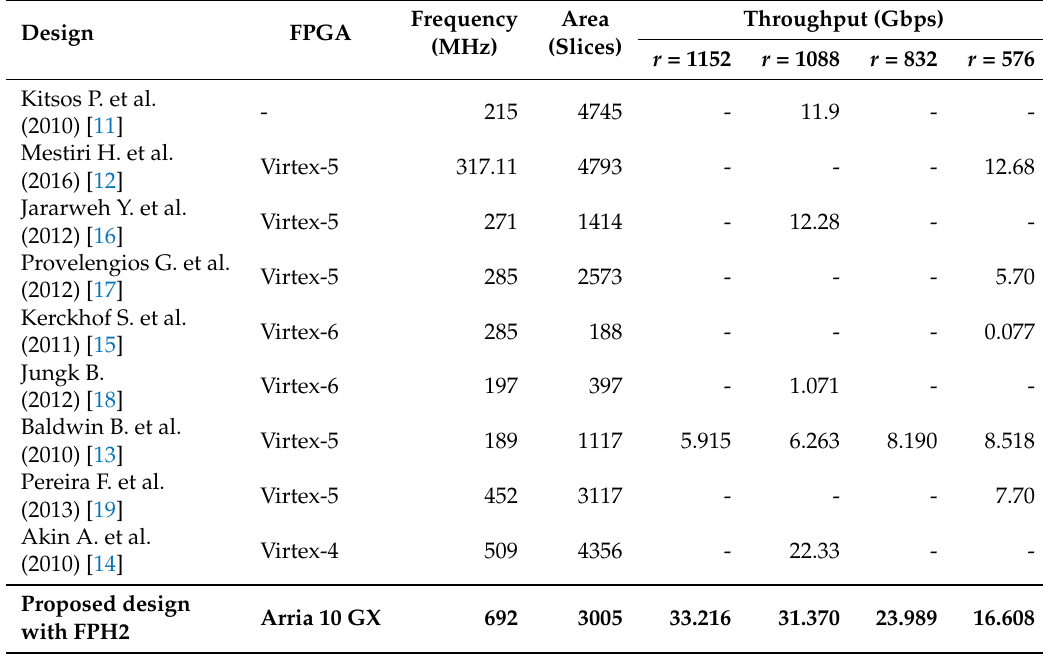
Table 7. Throughput results and comparison. With bold is ours experimental results.